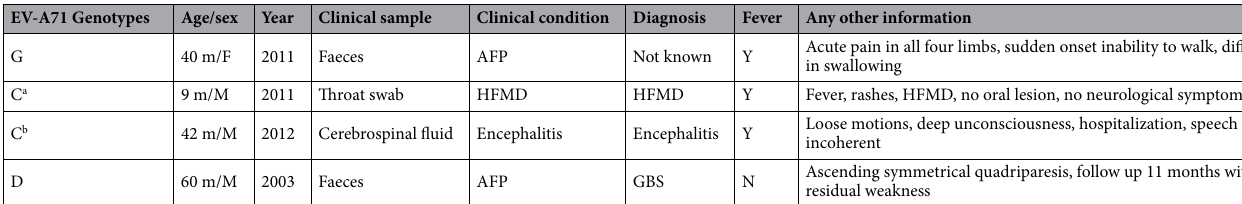
Table 1. Genotypes of EV-A71 isolated from clinically different patients from India. AFP acute flaccid paralysis. a Referred as C (HFMD) in the text for comparison between two clinically different C genotype isolates. b Referred as C (Enc) in the text for comparison between two clinically different C genotype